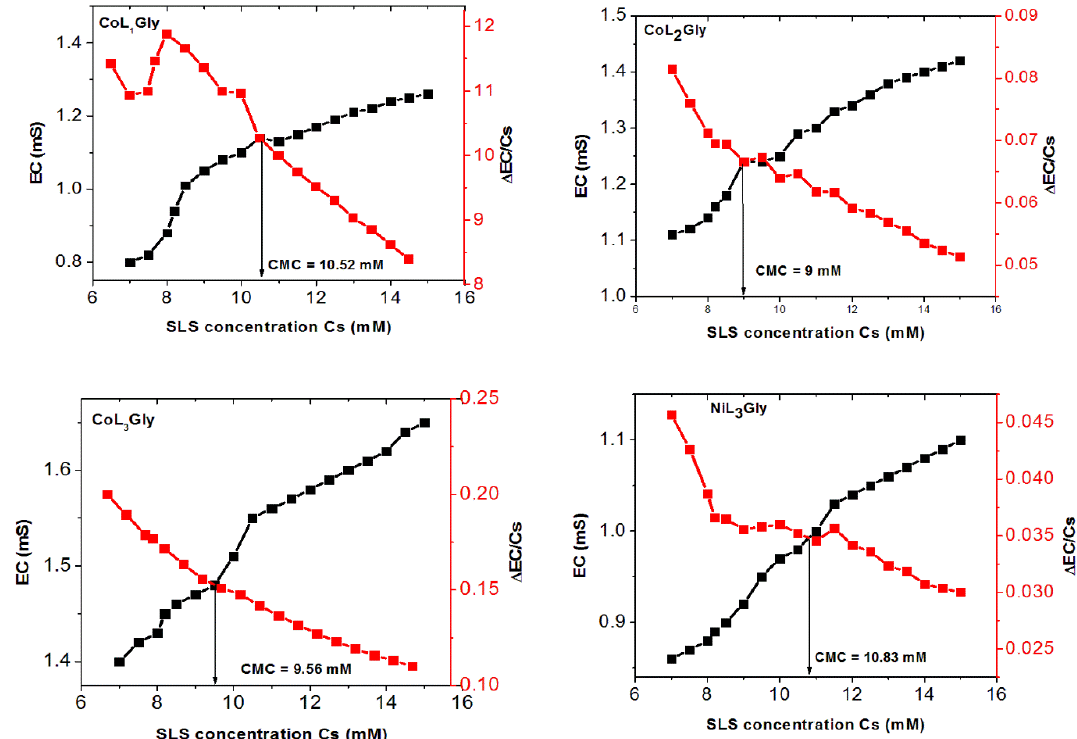
Figure 2. Plots of conductivity and differential conductivity vs. (sodium lauryl sulfate) SLS concentrations.